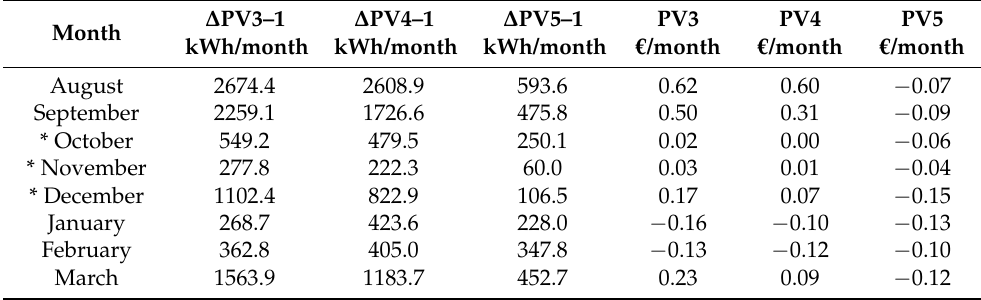
Table 8. Monthly energy increments produced by the cooling systems and economic benefits